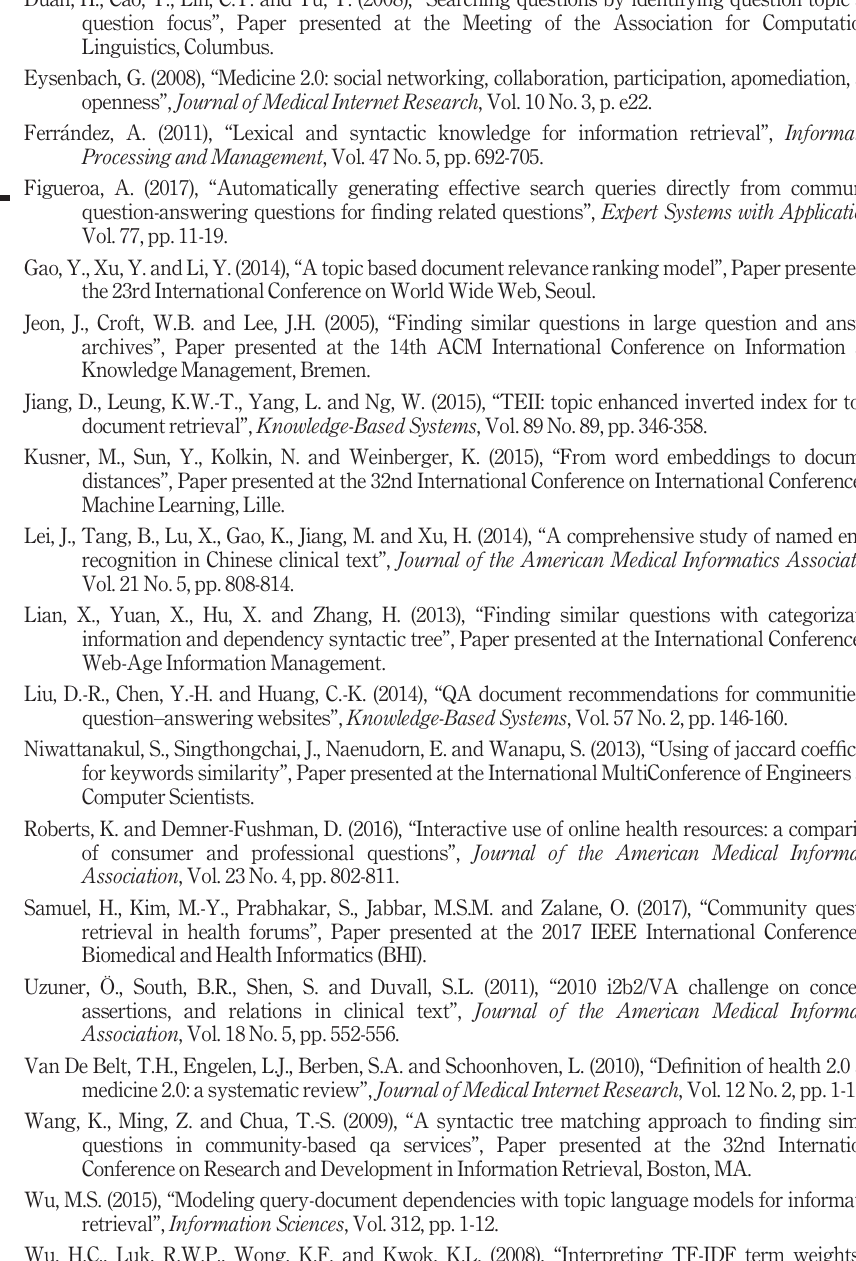
Figueroa, A. (2017), “ Automatically generating effective search queries directly from community question-answering questions for fi nding related questions ” , Expert Systems with Applications , Vol. 77, pp.